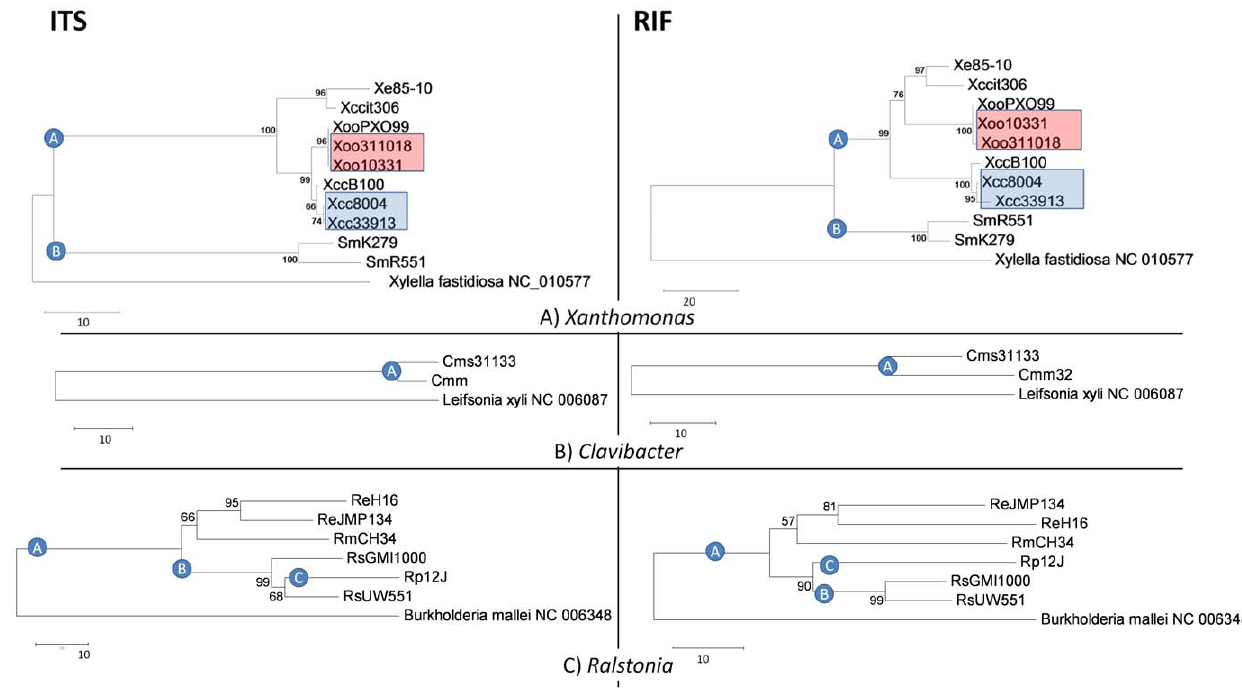
Figure 2. Neighbor-joining cladograms for Xanthomonas , Clavibacter and Ralstonia using ITS and RIF sequences. RIF resolves closely related strains of Xanthomonas that remain unresolved with ITS. The neighbor-joining cladograms for A) Xanthomonas , B) Clavibacter and C) Ralstonia using the ITS and RIF markers from fully sequenced strains in GenBank (Table 1). Bootstrap values . 50% (shown at the node) are expressed as a percentage of 5,000 replicates. Red boxes contain two X. oryzae pv. oryzae strains resolved by one SNP between RIF sequences and zero SNPs between ITS sequences. Likewise, blue boxes contain two X. campestris pv. campestris strains resolved by five SNPs between RIF sequences and zero SNPs between ITS sequences. The RIF and ITS sequences of Xoo strains 10331 and PXO99 are identical. Xylella fastidiosa , Burkholderia mallei and Leifsonia xyli are included as outgroups.